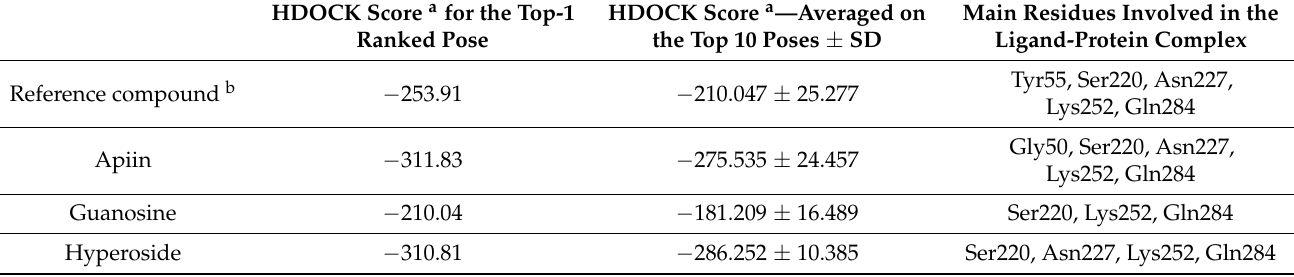
Table 1. Ligand/NF-kB complexation: HDOCK docking scores (for the top ranked poses and averaged on the Top-1–10 poses). The main amino acids involved in the ligand/protein complexes for the Reference compound and each plant metabolite are reported in the last column. HDOCK Score a for the Top-1 HDOCK Score a —Averaged on Main Residues Involved in the Ranked Pose the Top 10 Poses ± SD Ligand-Protein Complex Reference compound b −